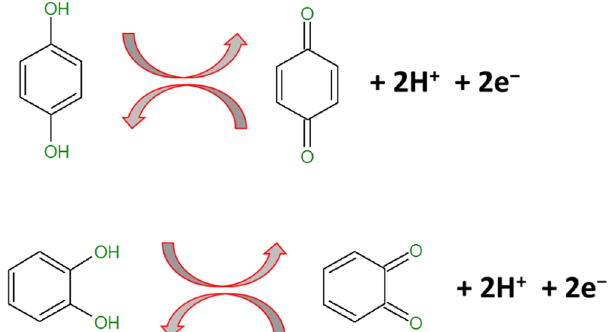
Figure 9. Electrooxidation mechanism of HQ and CC.